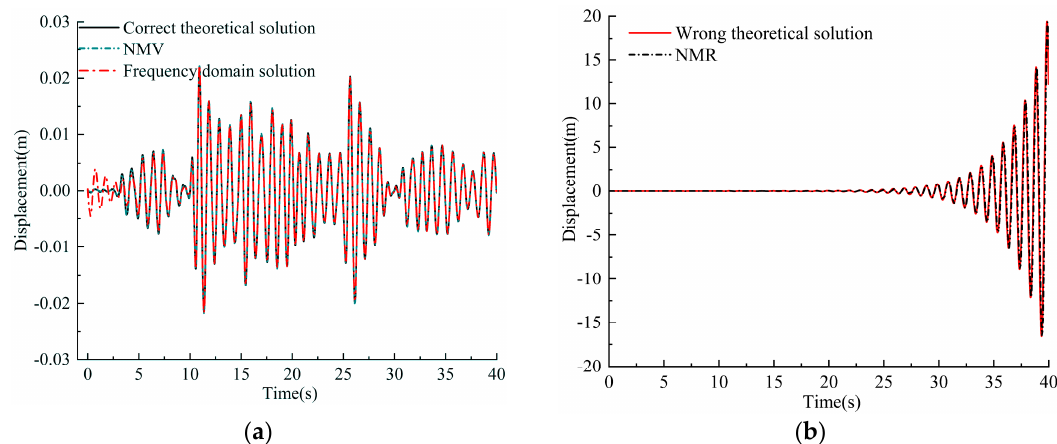
Figure 4. Forced vibration solution with arbitrary loading: ( a ) correct theoretical solution, NMV, frequency domain solution; ( b ) wrong theoretical solution and NMR.